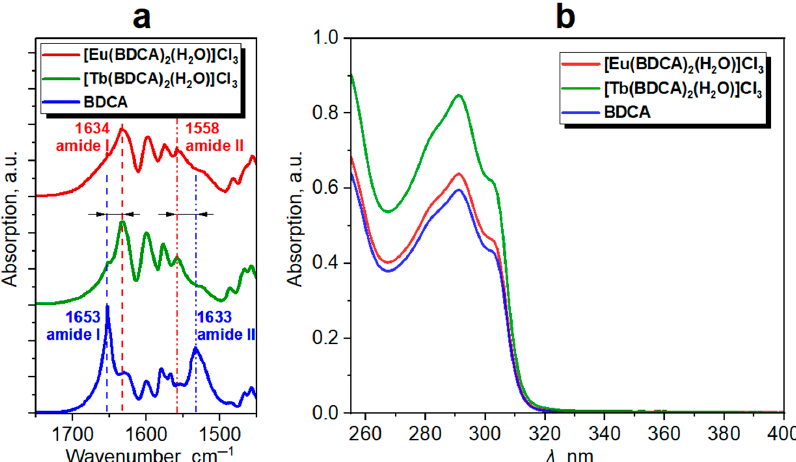
Figure 2. Spectra of [Eu(BDCA) 2 (H 2 O)]Cl 3 , [Tb(BDCA) 2 (H 2 O)]Cl 3 , and BDCA: FTIR in KBr ( a ) and UV-vis in DMSO ( b ) . UV-vis in DMSO ( b